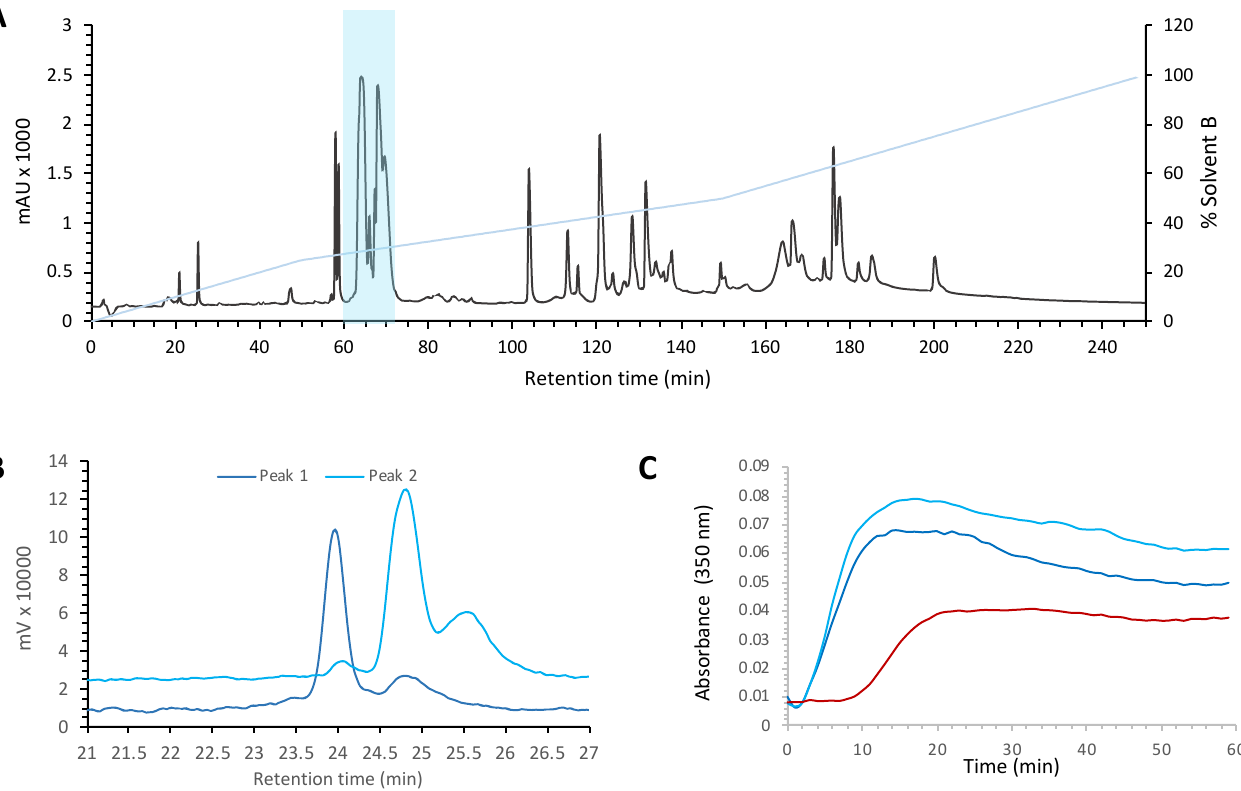
Figure 1. Purification of myotoxin-3 from Crotalus oreganus oreganus venom. ( A ) Preparative HPLC chromatogram of C. o. oreganus venom. The position of the fraction B4 is highlighted ( B ) Superposed profiles (214 nm) of peaks present in the sub-fraction B4-24, peak 1 (dark blue) and peak 2 (light blue), loaded separately on analytical RP-HPLC column. ( C ) Tubulin polymerization assay in the absence (red line) or in the presence of peak 1 (dark blue) or peak 2 (light blue). The increase in turbidity at 350 nm indicates polymerization of the αβ -tubulin